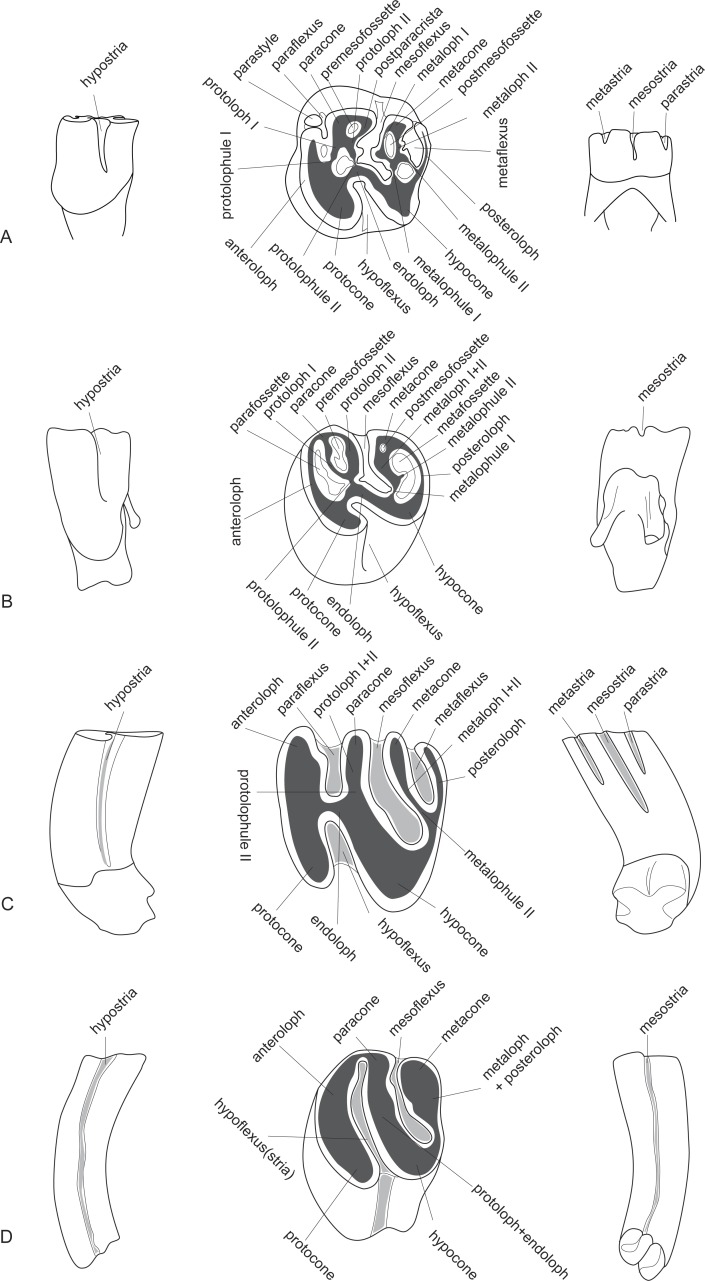
The upper dental structure of the Castoridae after the example of the moderately worn fourth premolars of Propalaeocastor irtyshensis.(A) Propalaeocastor; (B) Steneofiber; (C) Castor; (D) Dipoides. From left to right: lingual view, occlusal view, buccal view. Enamel = white, dentine = dark grey, cement = light grey, -fossette = -flexus = -stria. Modified from Stirton (1935), Hugueney (1975), Hugueney (1999), Lopatin (2003) and Wu et al. (2004).